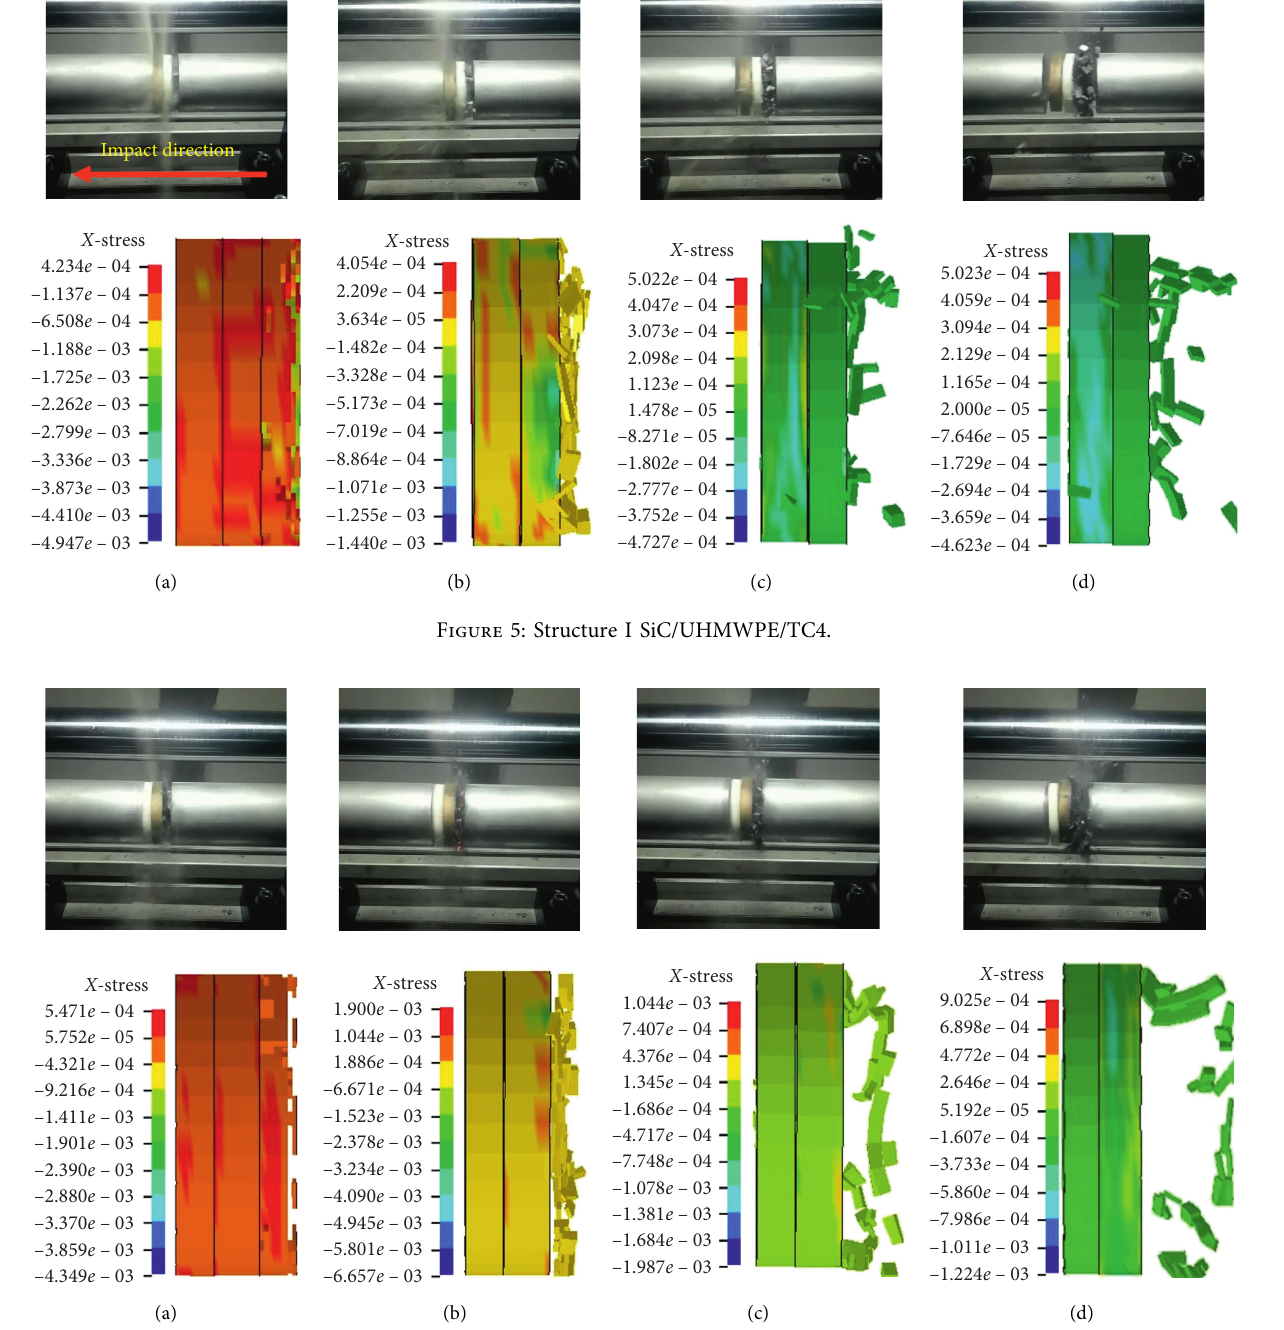
Figure 6: Structure II